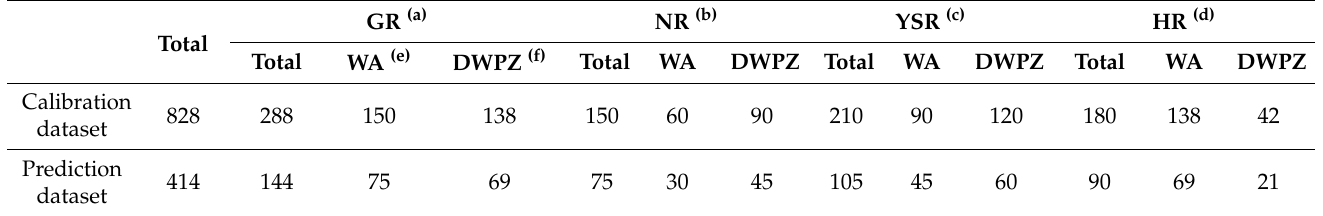
Table 1. Datasets used to develop and validate PLSR and SVR models for predicting SOM